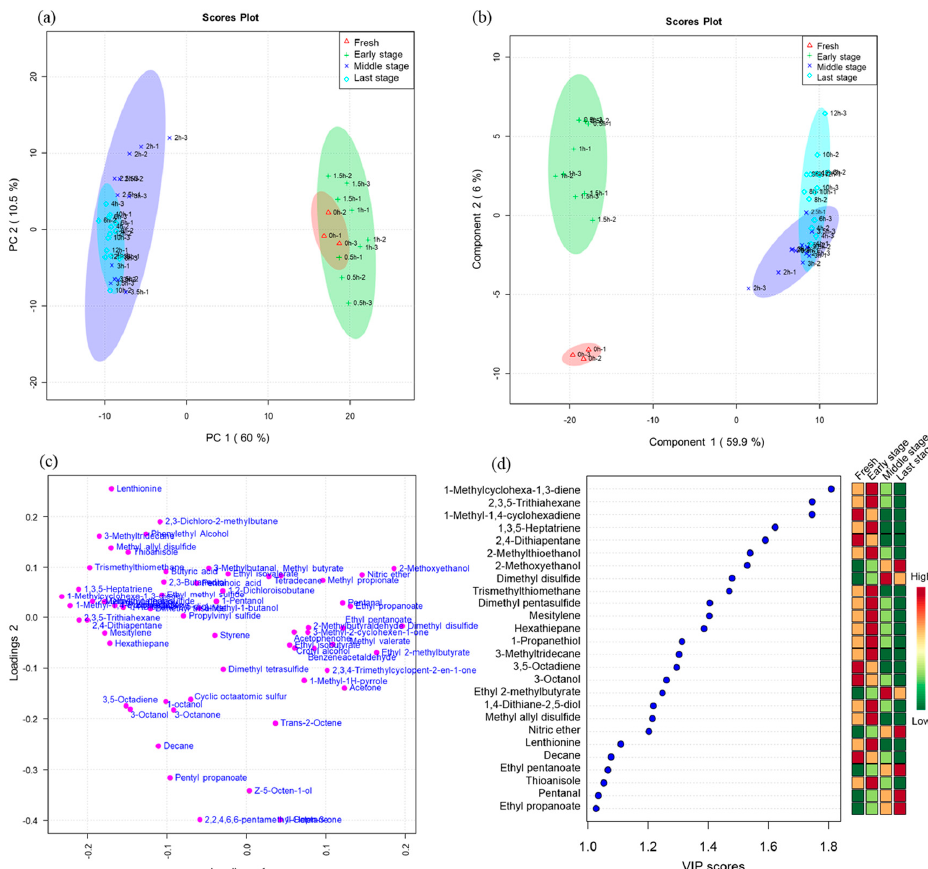
Figure 5. PCA of purge and trap combined with gas chromatography-mass spectrometry (PT-GC-MS) data for Lentinus edodes at di ff erent drying times. ( a ) PCA scores scatter plot. ( b ) Partial least-squares discriminant analysis (PLS-DA) scores scatter plot. ( c ) Loading plot of PLS-DA. ( d ) Important volatiles (VIP > 1) identified by PLS-DA. The colored boxes on the right indicate the relative concentrations of the corresponding volatiles in di ff erent drying stages.